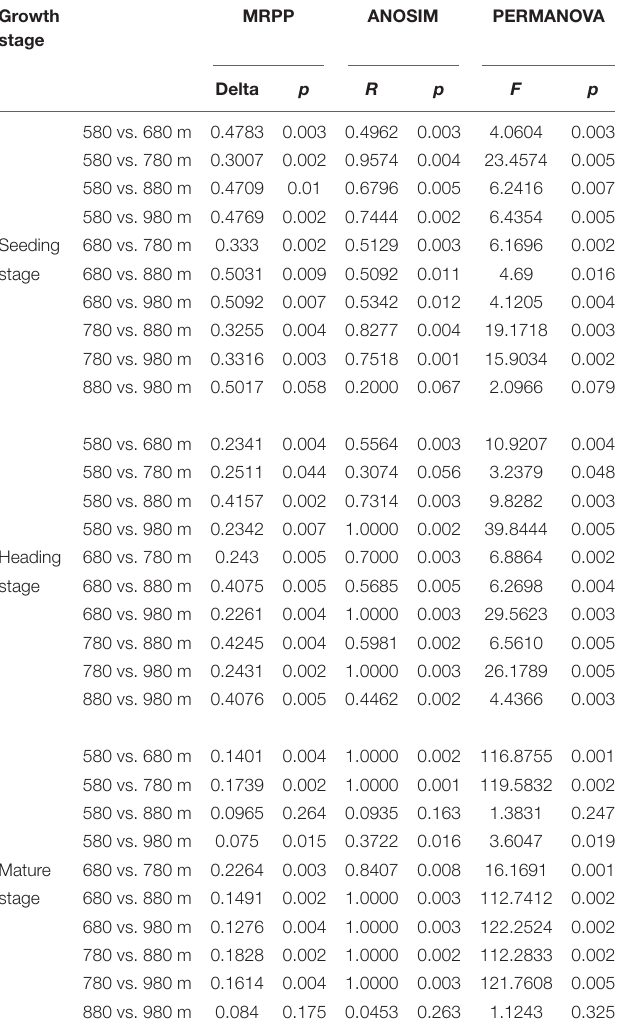
TABLE 4 | Dissimilarity test of phyllosphere bacterial community between two different sample groups among different elevations at the seedling, heading, and mature stages.